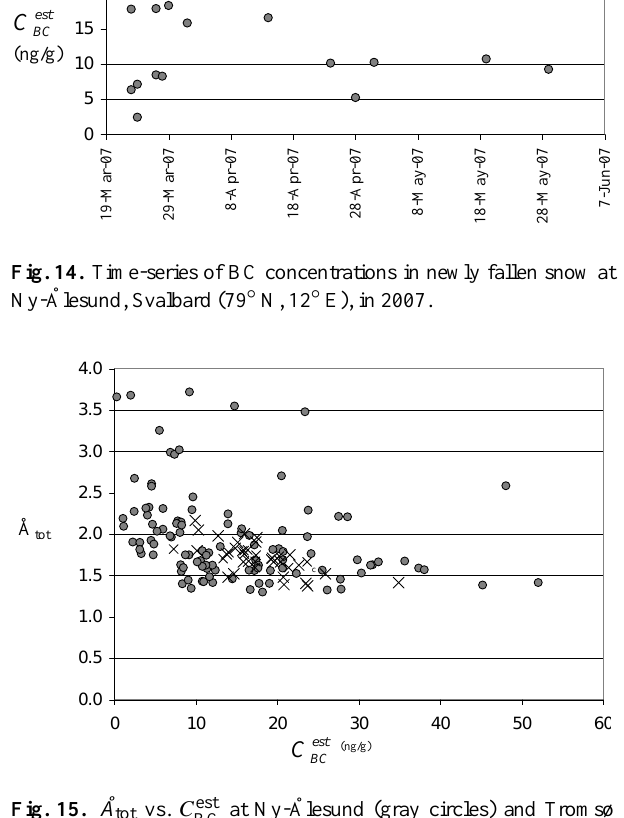
(c) non-uniformity in the deposition of sample aerosol onto the nuclepore filters, which may introduce random errors for some samples, and (d) the question of whether the samples analyzed are representative of a broader